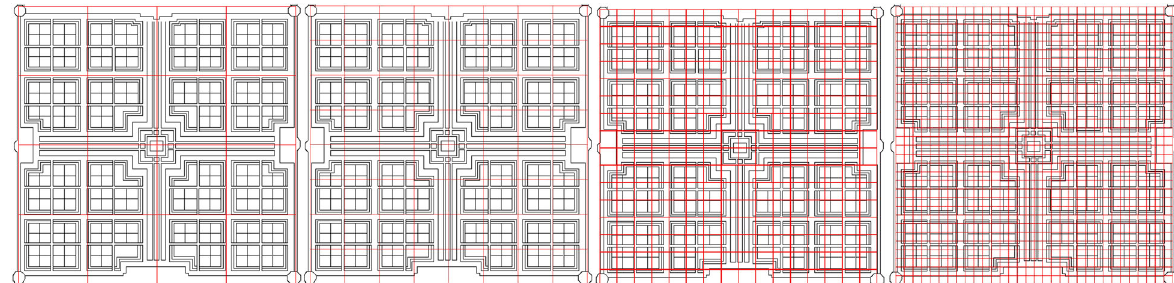
Fig. 5 A diagrammatic illustration of the Box-Counting Method applied to the Taj Mahal garden plan. Four successive grids are applied to range from l = 140 to l = 17, where l is the length of the sides of the boxes (in pixels). This illustration does not show the grid rotation and the random placements of grids effectively carried out by the software BENOIT TM